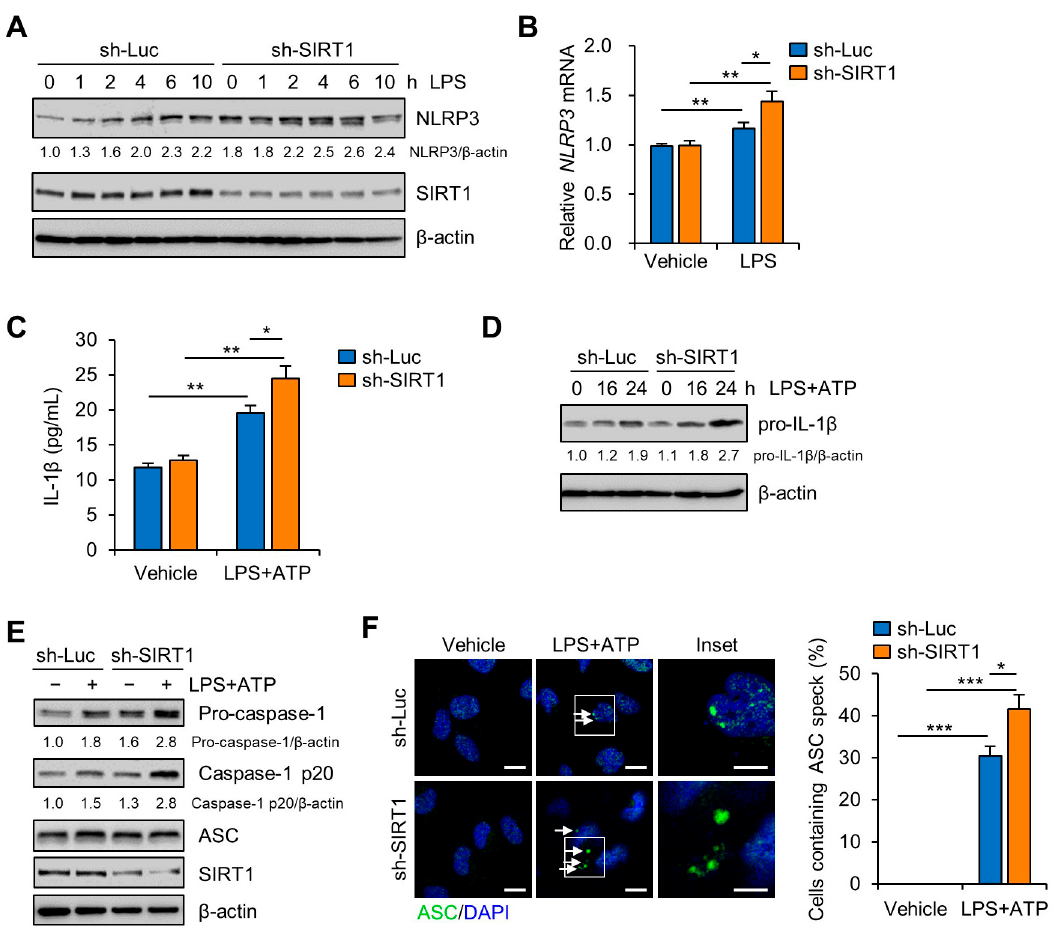
Figure 3. SIRT1 knockdown enhances LPS-induced NLRP3 inflammasome activation in trophoblasts. ( A ) Sw.71 cells were infected with lentiviruses expressing shRNAs targeting luciferase (sh-Luc) or SIRT1 (sh-SIRT1) and then treated with LPS (200 ng / mL) for the indicated time. Cell lysates were immunoblotted with anti-NLRP3 and anti-SIRT1 antibodies. ( B ) Relative mRNA expression of NLRP3 in Sw.71 cells infected with sh-Luc or sh-SIRT1 lentivirus and treated LPS (200 ng / mL) for 12 h. ( C ) Conditioned media were collected from Sw.71 cells infected with sh-Luc or sh-SIRT1 lentivirus and then treated or not (vehicle) with LPS (200 ng / mL) for 24 h, followed by ATP (5 mM) treatment for 45 min. Levels of IL-1 β in the conditioned media were quantified by ELISA. ( D ) Sw.71 cells were infected with sh-Luc or sh-SIRT1 lentivirus and then treated or not (vehicle) with LPS (200 ng / mL) for the indicated time, followed by ATP (5 mM) treatment for 45 min. Cell lysates were immunoblotted with anti-IL-1 β antibody. ( E , F ) Sw.71 cells were treated with LPS (100 ng / mL) for 24 h and then followed by ATP (5 mM) treatment for 45 min, or were treated with vehicle. ( E ) Cell lysates were immunoblotted with anti-caspase-1, anti-ASC, and anti-SIRT1 antibodies. ( F ) Immunofluorescence staining of ASC (green). The white arrow represents ASC specks. Nuclei were stained with DAPI (blue). Scale bars, 20 µ m; inset, 10 µ m. Endogenous ASC specks were quantified. β -Actin served as a loading control. Numbers below the immunoblot bands indicate the fold changes normalized to the control bands. Data are shown as mean ± S.E.M. Results are representative of at least three independent experiments. * p < 0.05; ** p < 0.01; *** p < 0.001 (Student’s t -test).